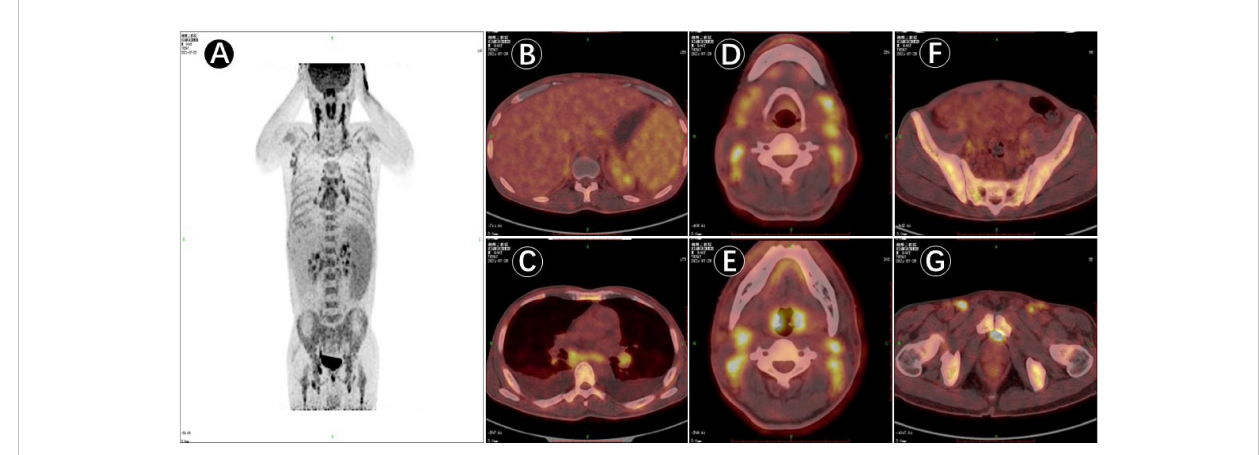
FIGURE 1 PET/CT image of 18 F-deoxyglucose (FDG) uptake in the patient (male, 45 years of age) with multiple lymph node enlargement. (A) . PET/CT maximum intensity projection (MIP) image displaying multiple groups of metabolically elevated lymph nodes throughout the body, with bilaterally general symmetry and mildly increased splenic metabolism. (B – G) . Cross-sectional images in PET/CT showing generalized multiple enlarged lymph nodes, hepatosplenomegaly, and bilateral abnormally enlarged tonsils together with increased metabolism; and active involvement of generalized bone metabolism.